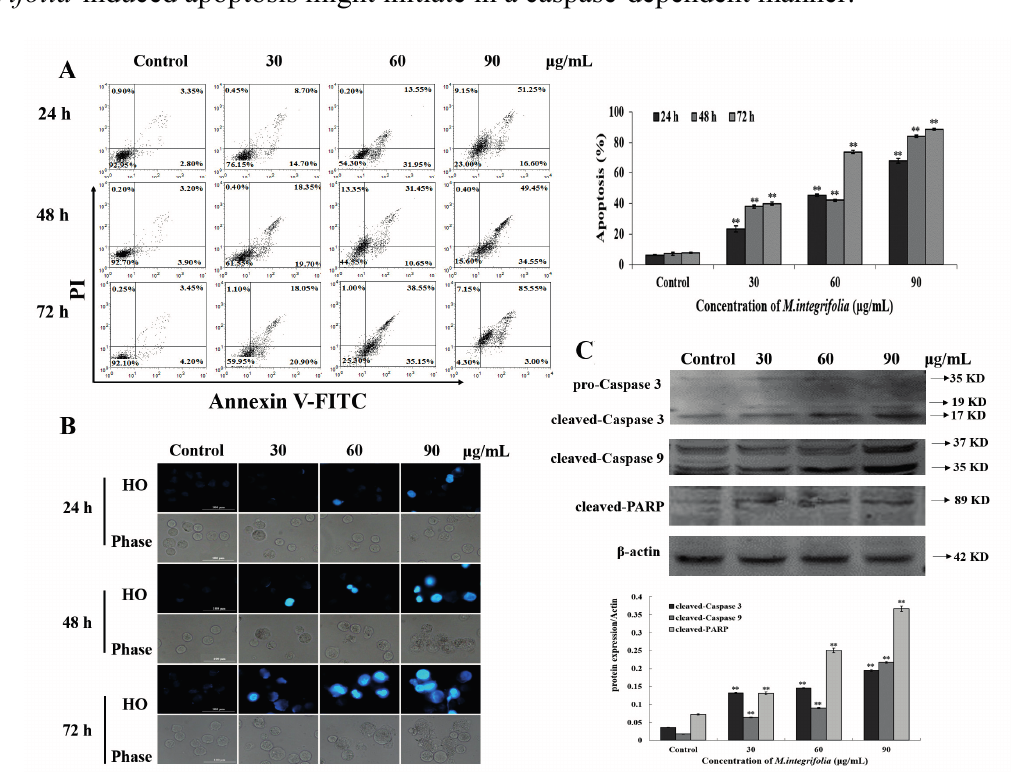
Figure 3. Apoptosis detection in M. integrifolia -treated cells. ( A ) The quantification of apoptotic cells. K562 Cells were double-stained with Annexin V-FITC and PI, and